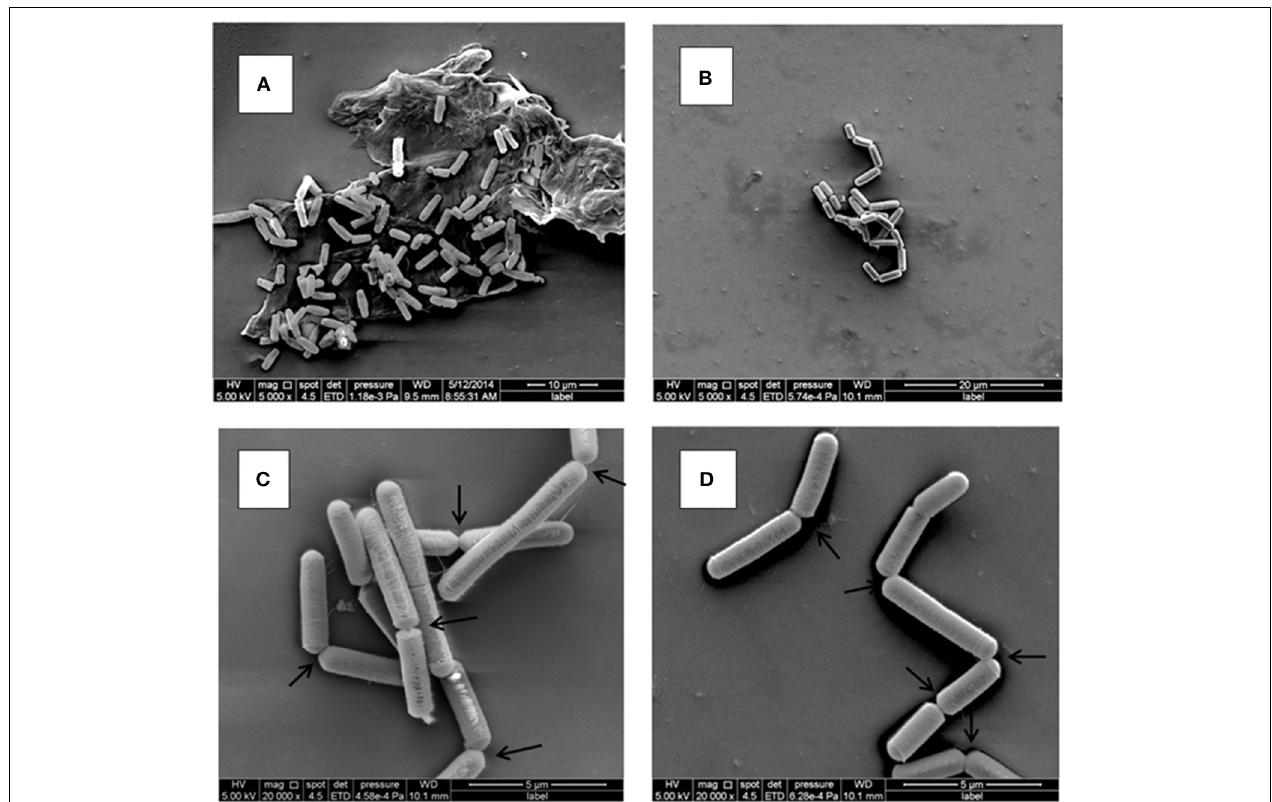
culture (KN in Figure 3A ). Arrows show some of the connections between the cells, organized as chains, indicating impaired cell